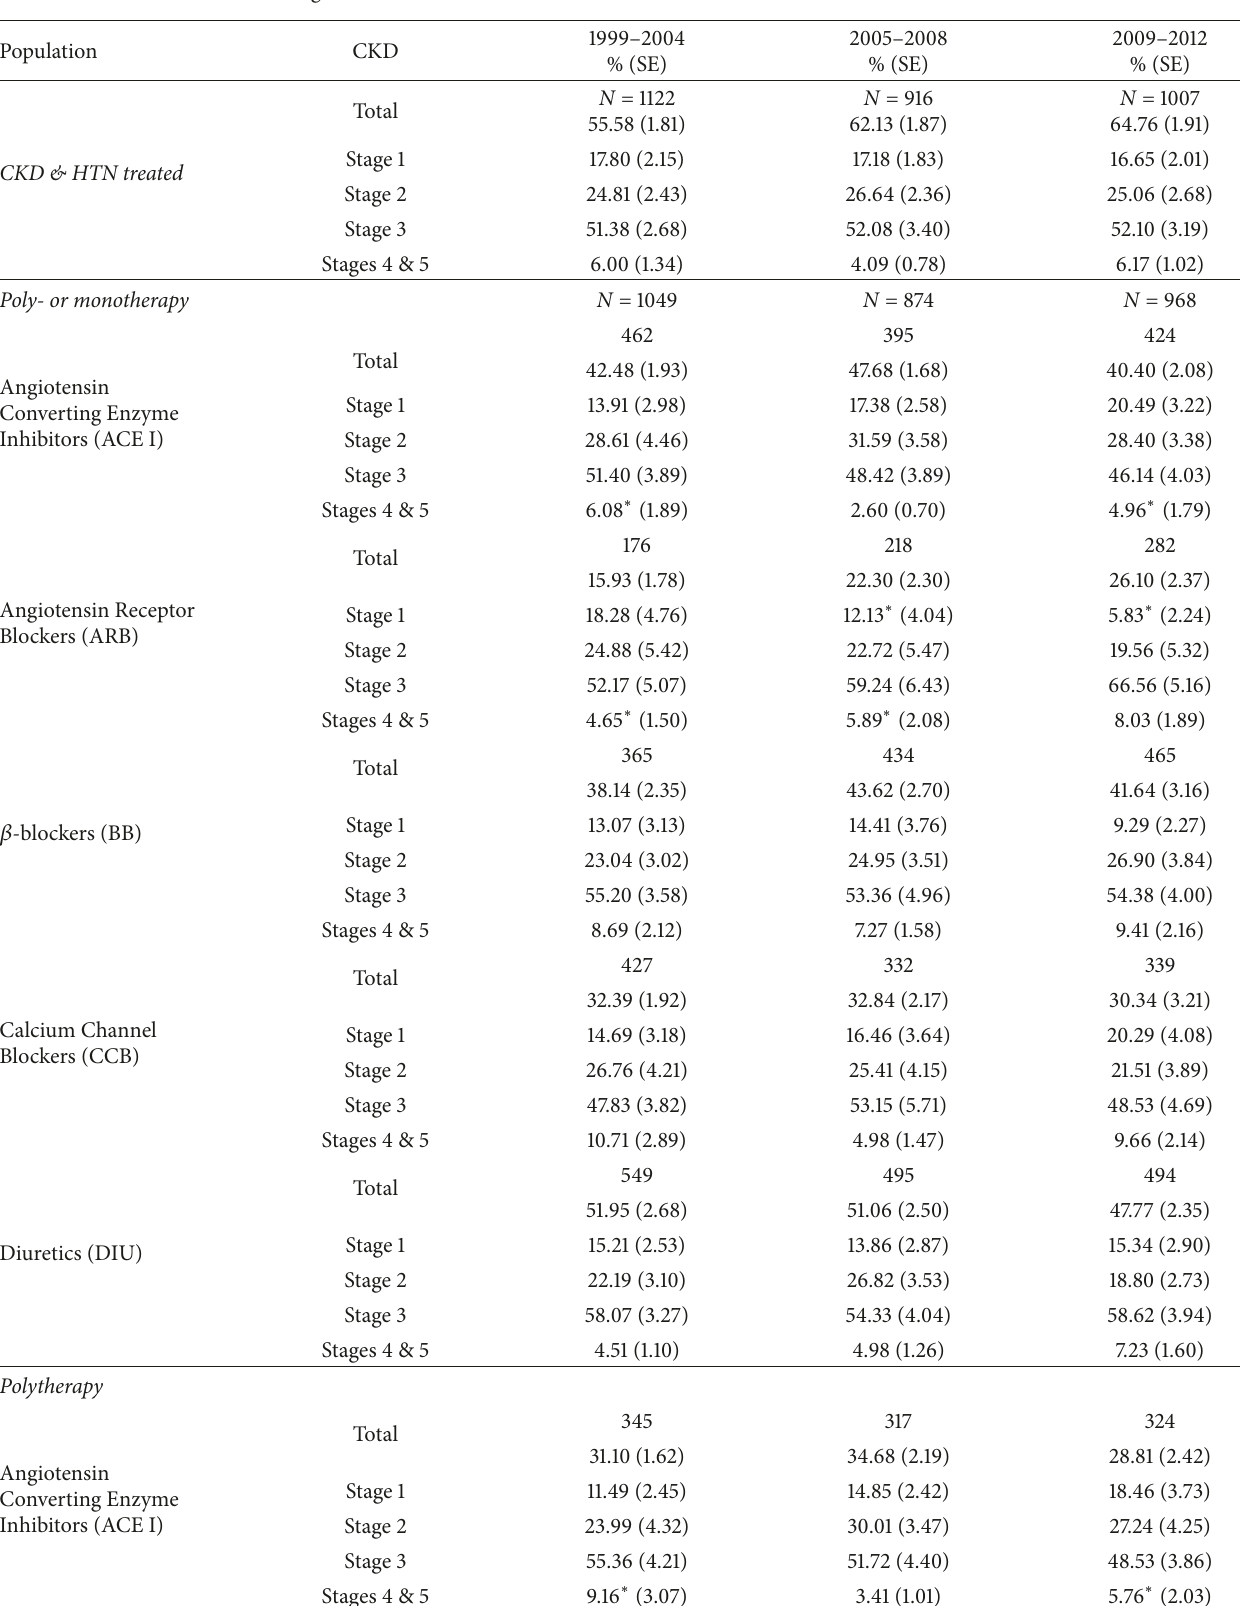
Table 1: Age-standardized $ prevalence of American adults (18 years of age or older) with hypertensive CKD treated for hypertension by five classes of medications and CKD stages: NHANES